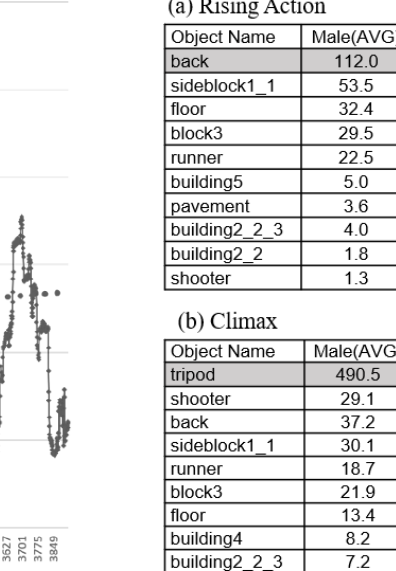
Figure 7. HIPV Group in the Rising Action and Climax (Standard Deviation ( left ) and Objects Most Seen ( right )).